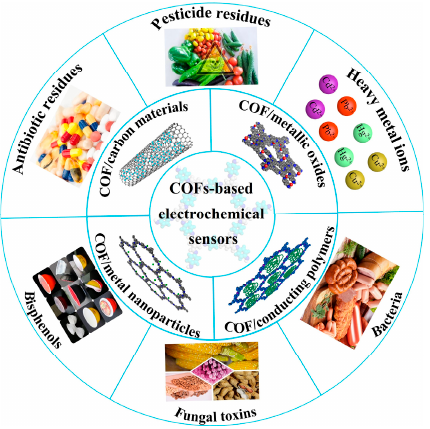
Figure 1. COF-based electrochemical sensors for food safety